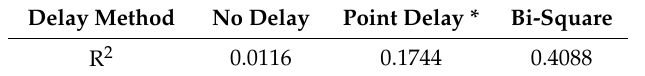
Table 6. Comparison of the three delay methods.